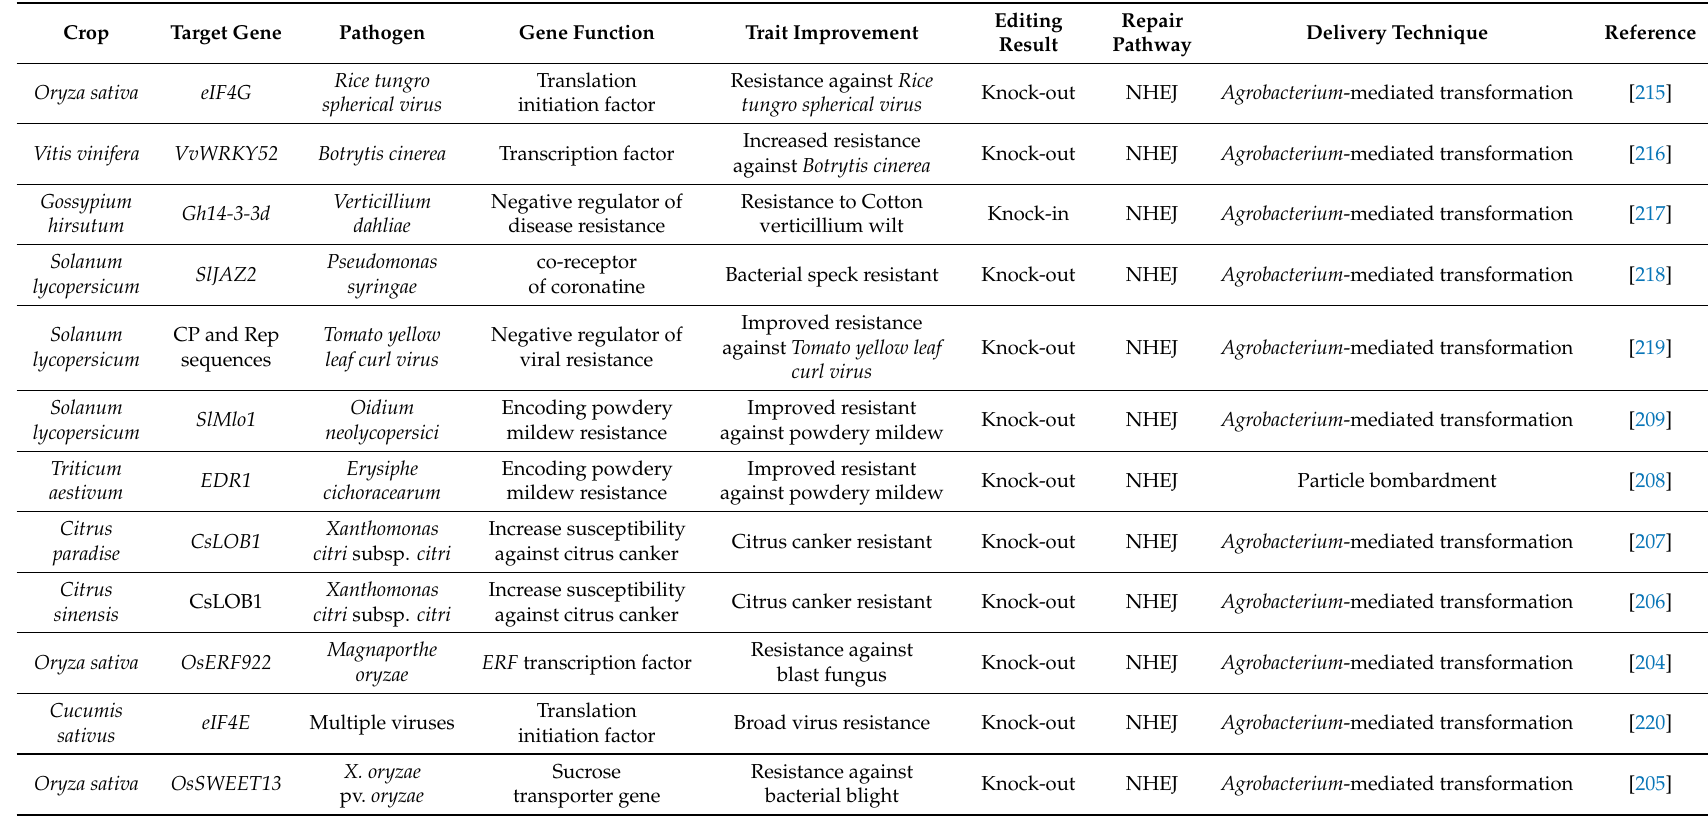
Table 3. Summary of disease-resistant crops developed via CRISPR /